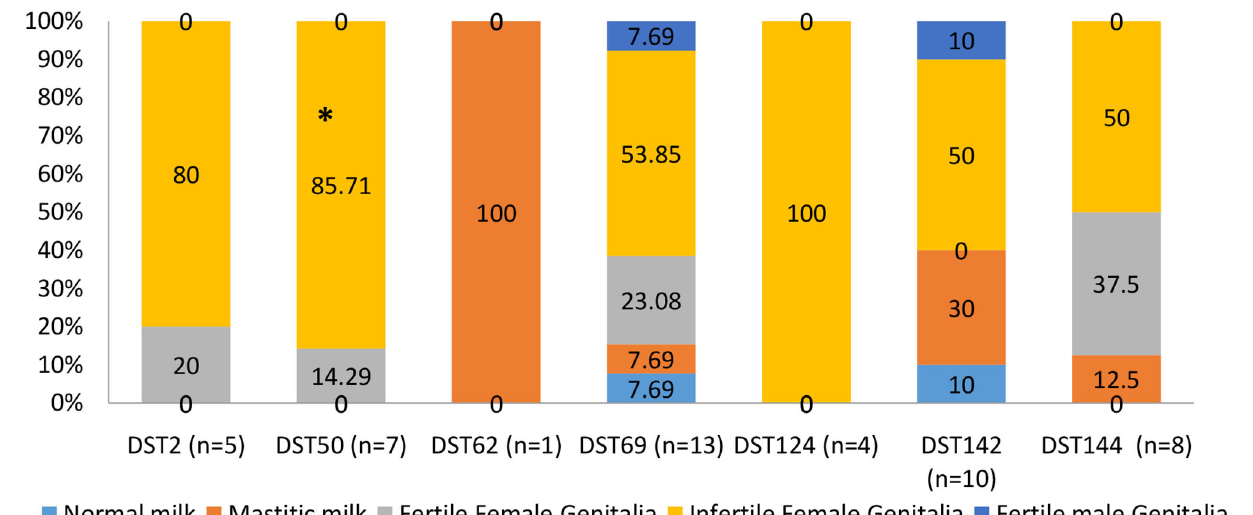
FIGURE 6 | The distribution of different diploid sequence types (DSTs) of C . albicans isolates in different collected samples of dromedary camels. *Percentage carrying asterisk within the same DSTs differed significantly ( p ≤ 0.05).